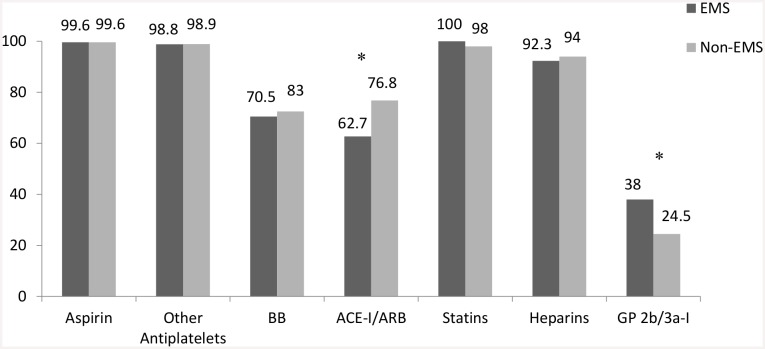
Evidence-based treatments administered in the first 24 hours of hospital admission in acute STEMI patients that arrived to the hospital by an emergency medical service (EMS) versus not (non-EMS).Other aniplatelets, clopidogrel, prasugrel, ticagrelor; BB, beta-blockers; ACE-I/ARB, angiotensin-converting enzyme inhibitors/Angiotensin-receptor blockers, Heparins, unfractionated or low-molecular weight heparin; GP 2b/3a-I, glycoprotein 2bb/3a inhibitors.